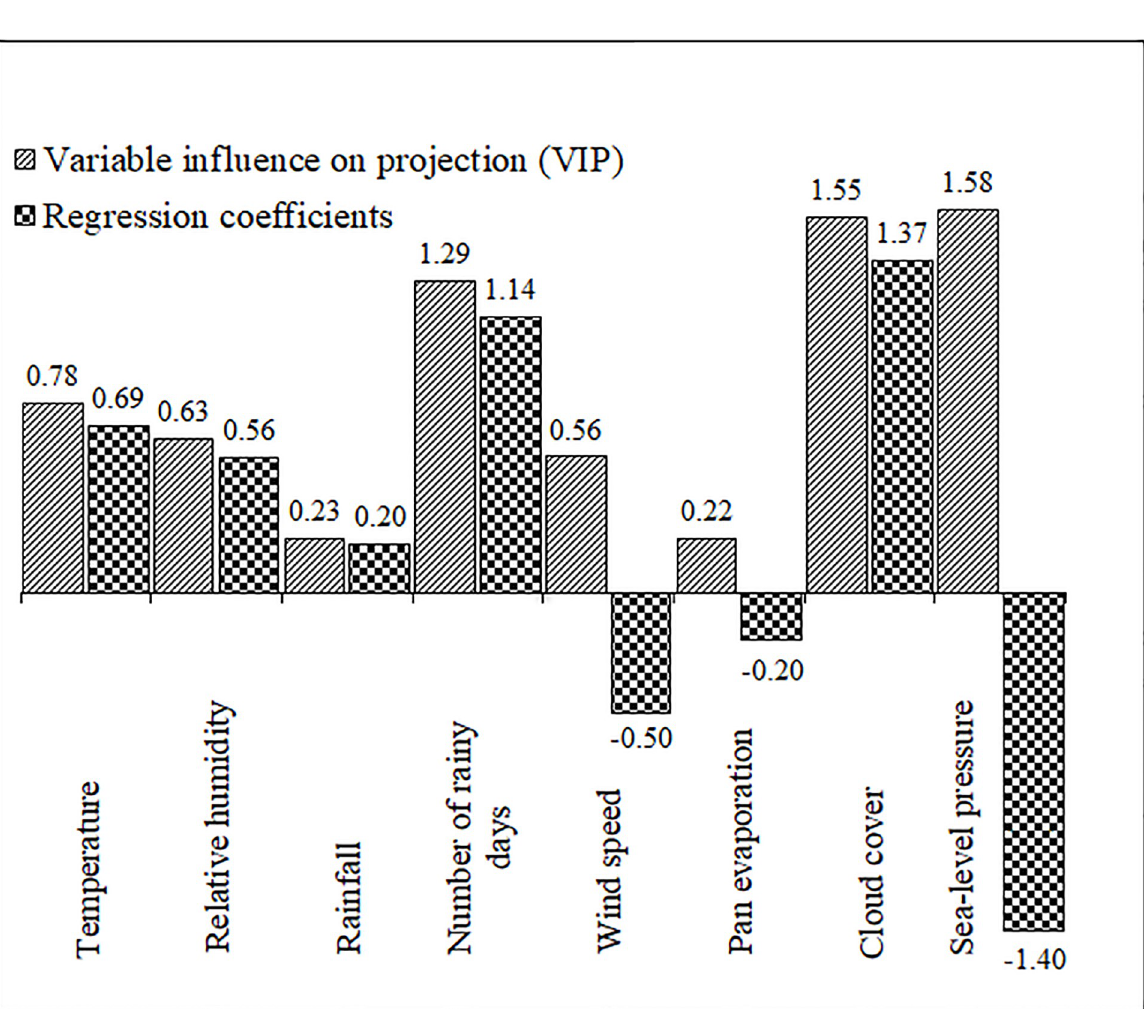
Fig 3. Sorting of the predictors according to their variable influence on projection values and regression coefficients. Higher values indicate greater variance explained in the partial least squares regression.